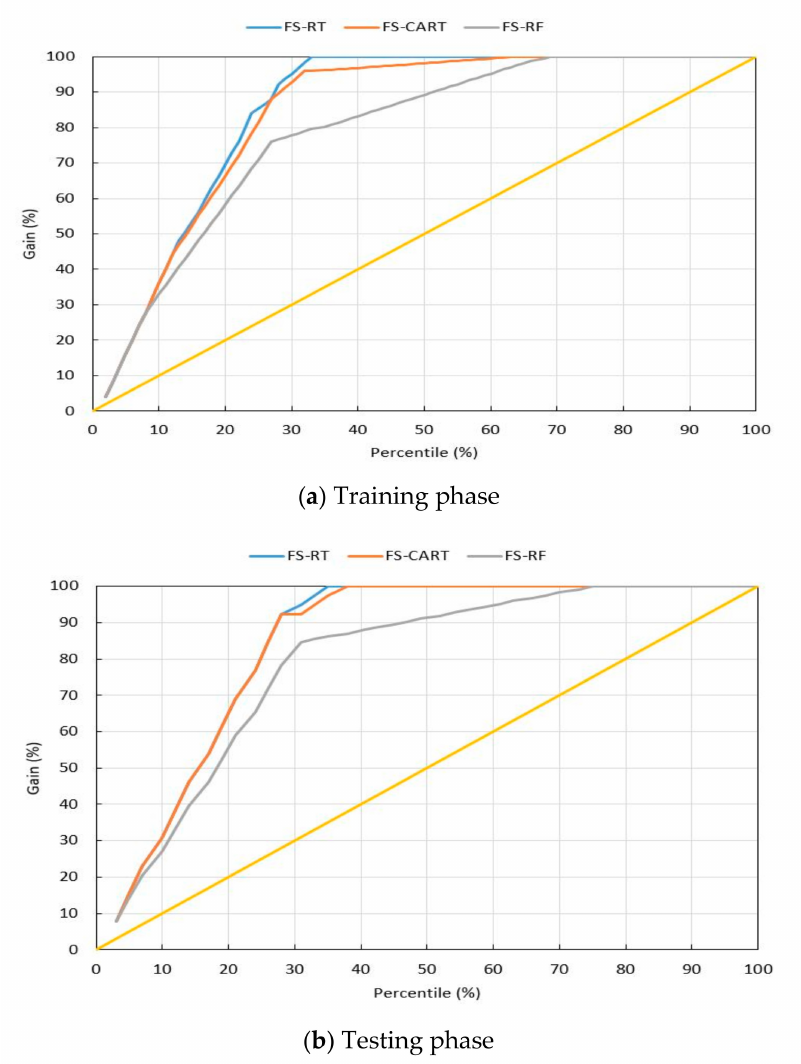
Figure 9. The gain chart of the hybrid models. ( a ) training phase, ( b ) testing phase.